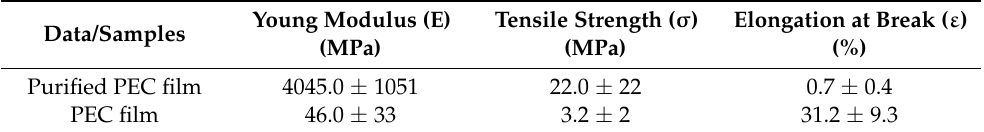
Figure 4. Thermogravimetric analysis (TGA) ( a ) and Derivative Thermogravimetry (DTG) ( b ) thermograms of all pectins and the lignocellulose residue solid. Table 4. Mechanical properties (tensile test) of Purified PEC and PEC films. Table 4. Mechanical properties (tensile test) of Purified PEC and PEC films.